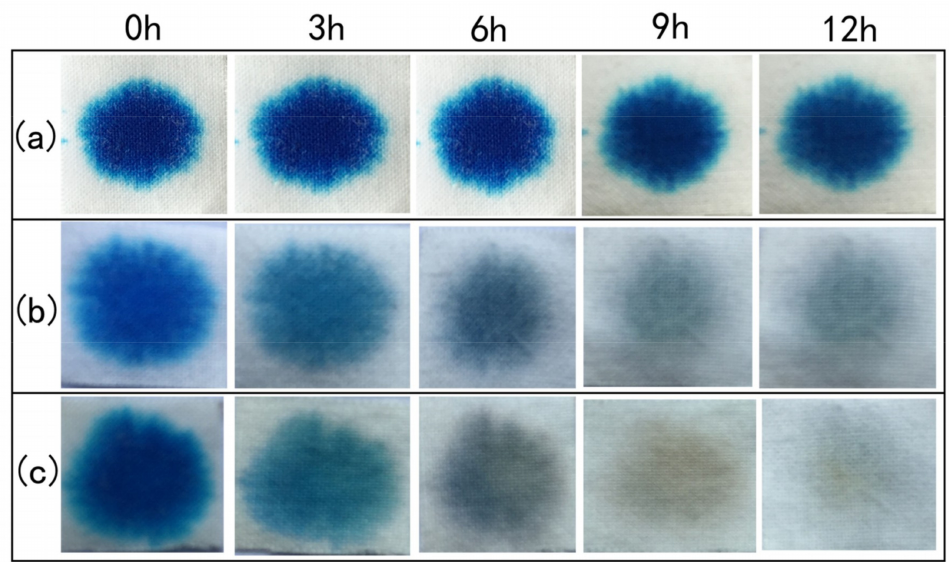
Figure 9. Images of photocatalytic degradation of MB stains on pristine ( a ) CHP, ( b ) CHP-IP6, and ( c ) cotton fabrics on exposure to solar irradiation.